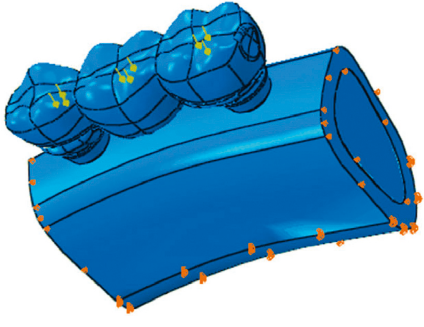
Figure 2: Tripod loading.